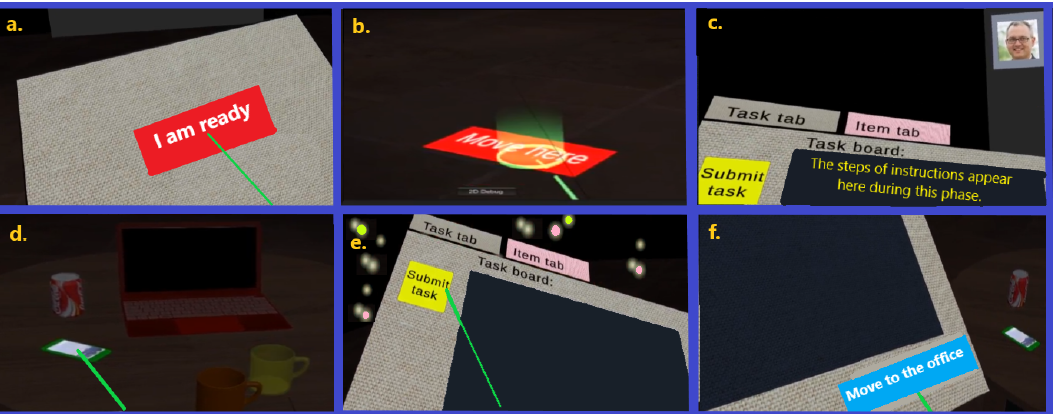
Figure 2. Screenshots showing some steps of the familiarization phase, from left to right: ( a ) selecting the “I am ready” button by the user; ( b ) teleporting to a destination; ( c ) reading instructions of the task from the panel on the user’s left hand; ( d ) removing an interactive object; ( e ) submitting the current task; ( f ) selecting the “Move to the office” button to move